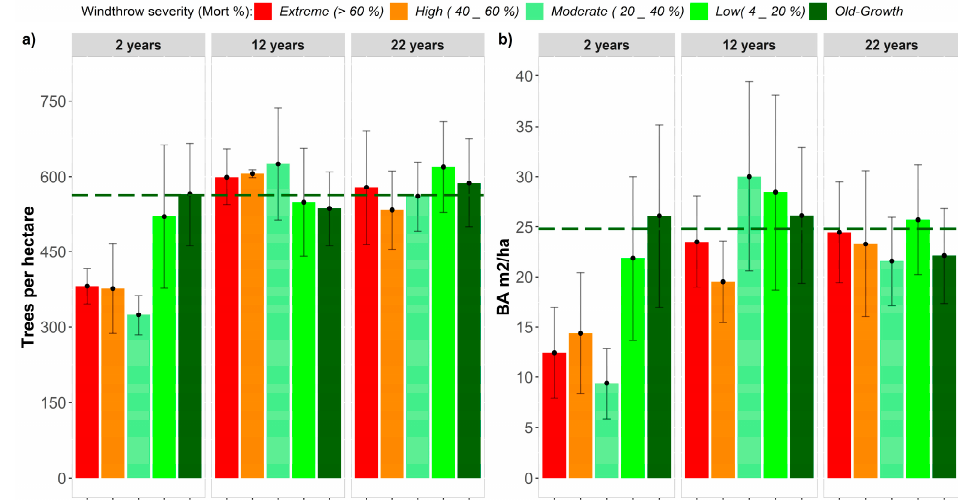
Figure 2. Recovery of ( a ) tree density (N tree ha − 1 ), and ( b ) mean basal area (m 2 ha − 1 ) of old-growth and windthrown forests across the range of severity classes at 2, 12, and 22 years after windthrow. 95% confidence intervals given by the error bars. Dashed dark green lines show the old-growth mean (of the three sites).